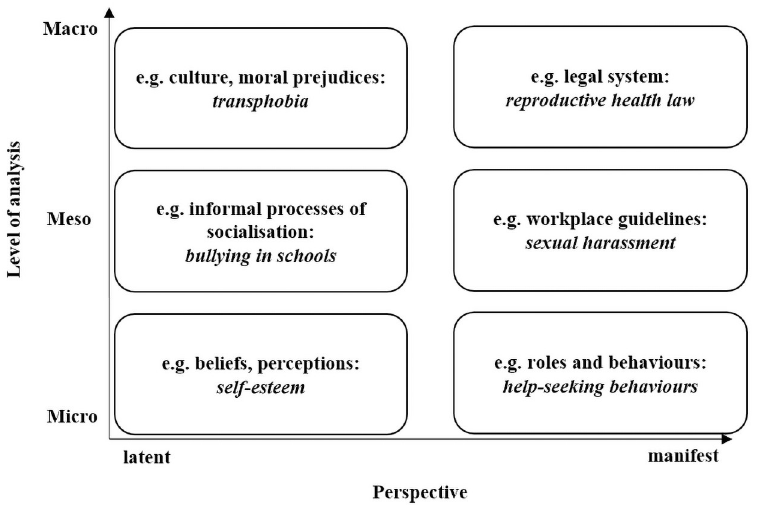
Fig 1. Multi-level approach to understanding the latent and manifest gender-related determinants of health. Source: Authors’ own elaboration, adapted from Ritzer [43].